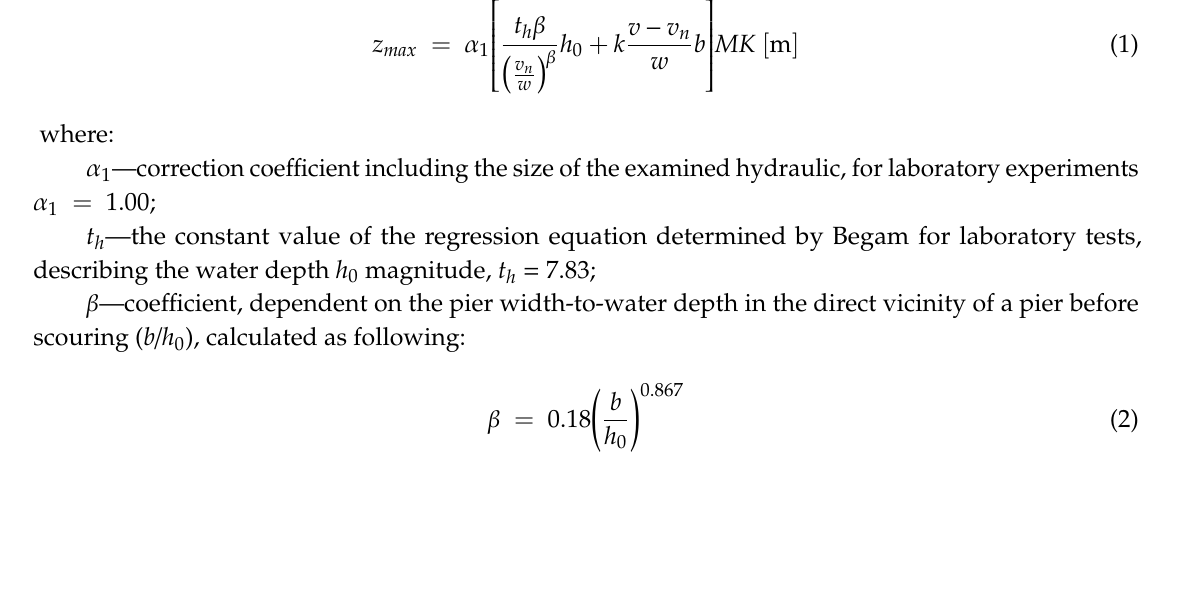
Figure 6. Local scour and pier model shape for Q w = 0.036 m 3 s − 1 , h 0 = 0.10 m (basing on own laboratory data).